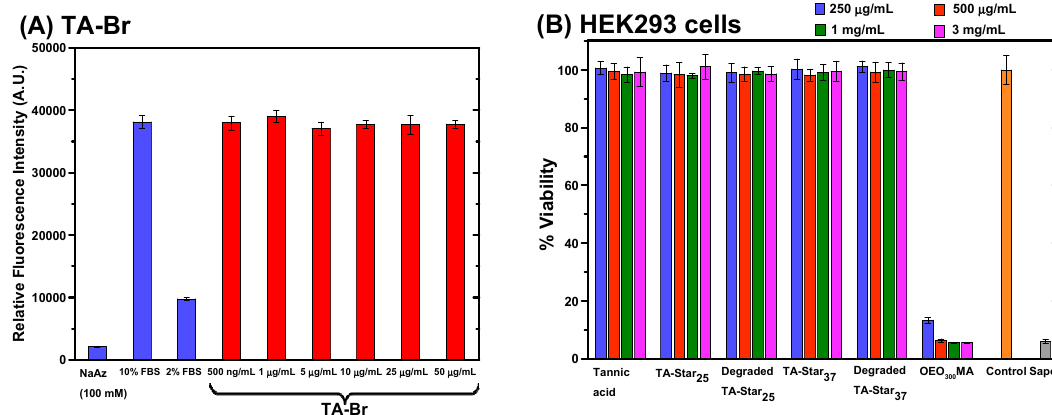
Figure 3. The cytotoxicity assays performed using HEK293 cells. ( A ) Assays of TA-Br at six concentrations (red) and the positive (FBS) and negative (NaAz) controls vs the relative fluorescence intensity. ( B ) The percent viability after 72 h of TA-P(OEO 300 MA) polymer stars, samples after degradation, and OEO 300 MA monomer at four concentrations from 250 µ g-3 mg / mL. Positive (orange) and negative controls (Saponin, grey) are also shown.